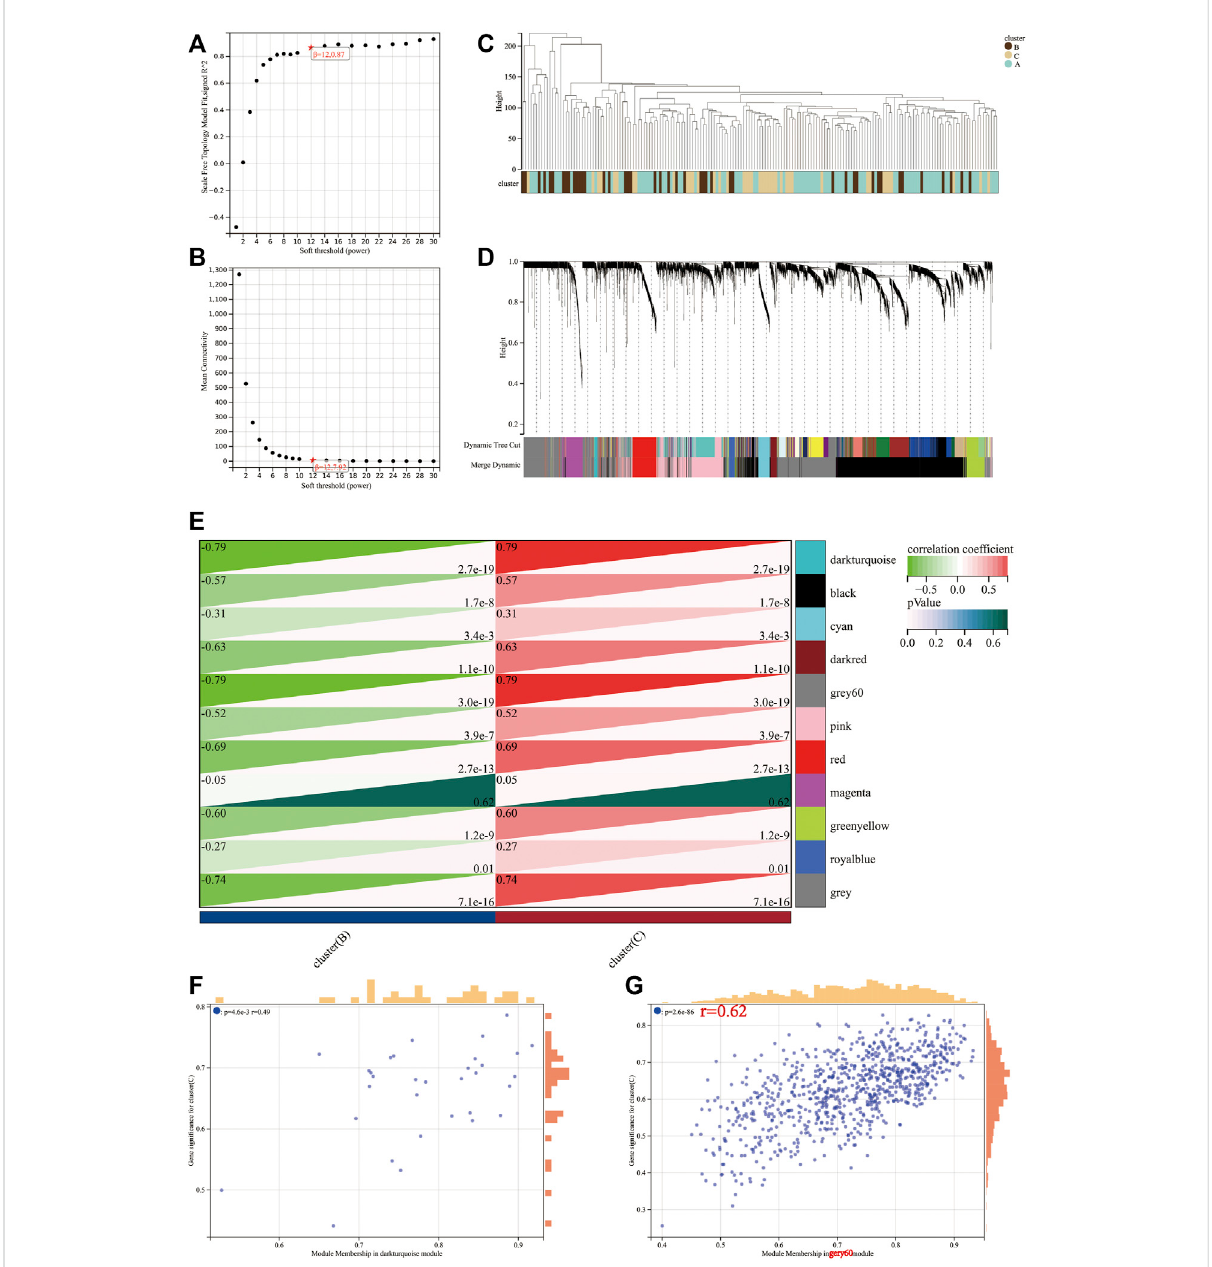
FIGURE 5 Determination of soft-threshold power in the WGCNA. (A) Analysis of the scale-free index for various soft-threshold powers ( β ). (B) Analysis of the mean connectivity for various soft-threshold powers. (C) Clustering dendrogram of 176 samples. Identi fi cation of modules closely associated with mitophagy subtypes. (D) Dendrogram of all differentially expressed genes clustered based on the measurement of dissimilarity (1-TOM). The color band shows the results obtained from the automatic single-block analysis. (E) Heatmap of the correlation between the module eigengenes and mitophagy subtype of PAAD. A scatterplot of gene signi fi cance (GS) for high mitophagy subtype (cluster C) versus module membership (MM) in the darkturquoise module (F) and gery60 module (G)